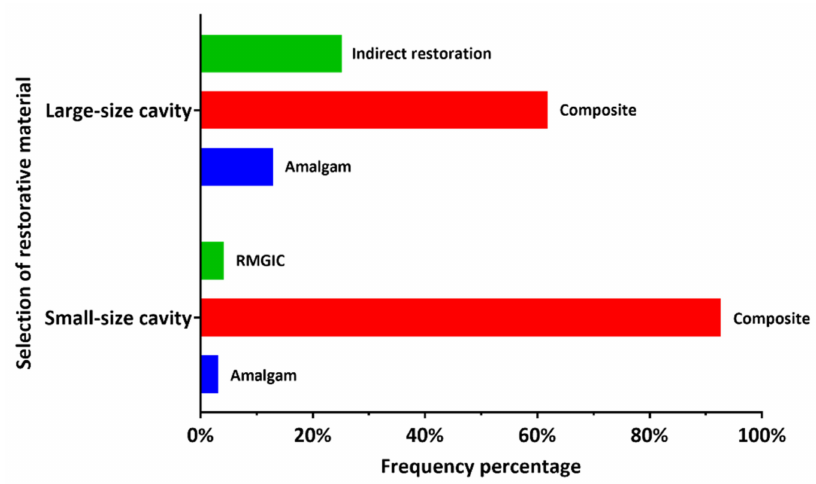
Figure 1. Dental practitioner-reported frequency of the selection of restorative material for small-size and large-size posterior cavity preparations (RMGIC: resin-modified glass ionomer cement). Table 2. Comparison between DPs working in the governmental and private sectors with regard to selection of restorative material and placement of composite in special